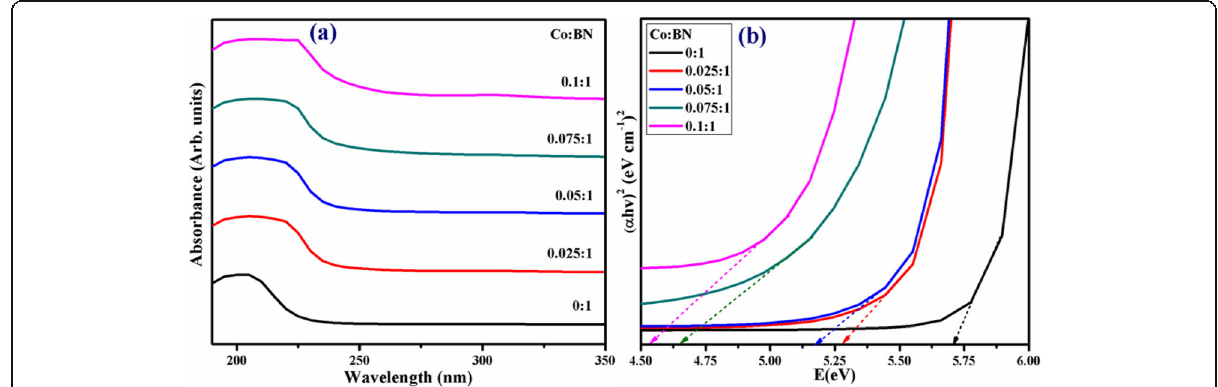
Fig. 5 a UV-vis spectra of bare and Co-doped BN-NS. b Tauc-plot for